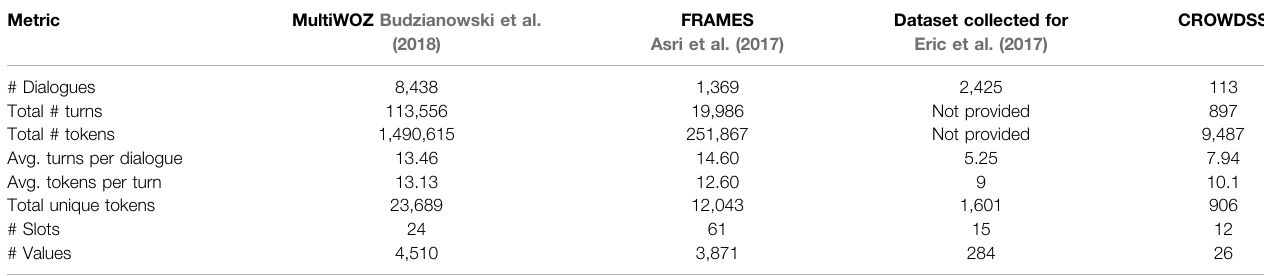
TABLE1| ComparisonofCROWDSSwithsimilardatasets(partiallyfromBudzianowskietal.,2018;numbersforMultiWOZandthedatasetcollectedforEricetal.,2017are for the training split, for FRAMES the division is not speci fi ed, for CROWDSS the numbers refer to the whole dataset). Metric MultiWOZ Budzianowski et al.